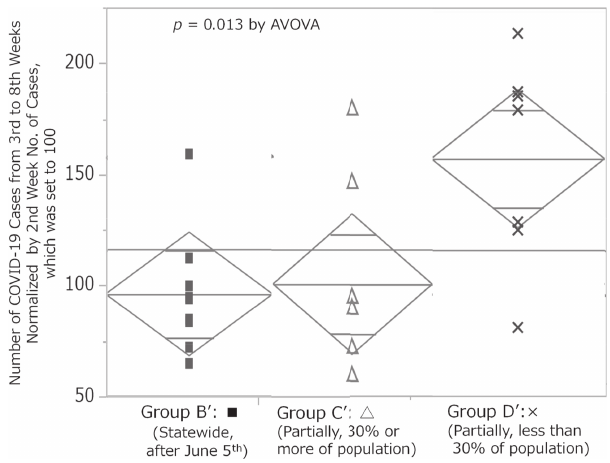
Note(s): Mobility was limited to less than 15%; Graphs show point estimates and 95% confidence intervals of population means